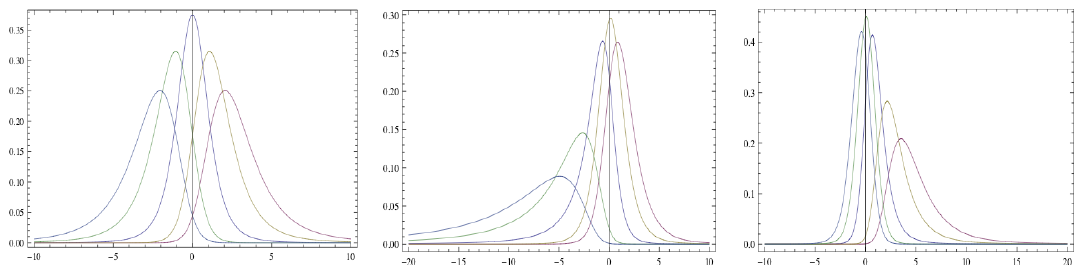
Figure 1. Graphics of the probability density function: left for the skewed t 1 (1) when ( a , b ) = (2,2), (5,2), (8,2), (2,5), and (2,8); center for the skewed t 2 (2) with ( a , b , c ) = (2,2,0.5), (8,2,0.5), (5,2,0.5), (2,5,0.5), and (2,8,0.5); and on the right, (2,2,2), (8,2,2), (5,2,2), (2,5,2), and